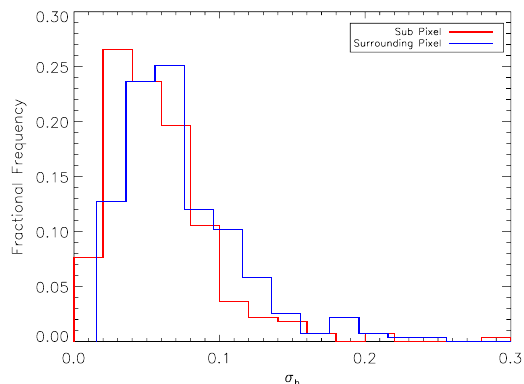
Fig. 14. Sub pixel and surrounding pixel homogeneity indices of all MODIS pixels used in the comparison